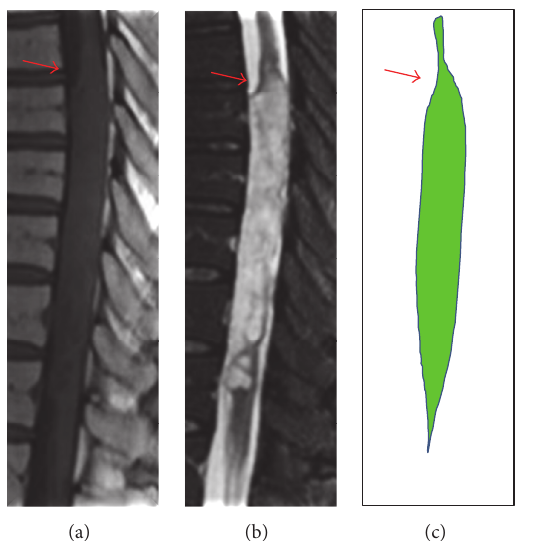
Figure 3: Bamboo leaf sign. The figure shows MRI of spinal subependymoma from our case. (a) T1WI. (b) T2WI. Sagittal MRI shows steep swelling of the spinal cord (arrows) and unusually large fusiform dilatation, resembling the shape of a bamboo leaf (c).